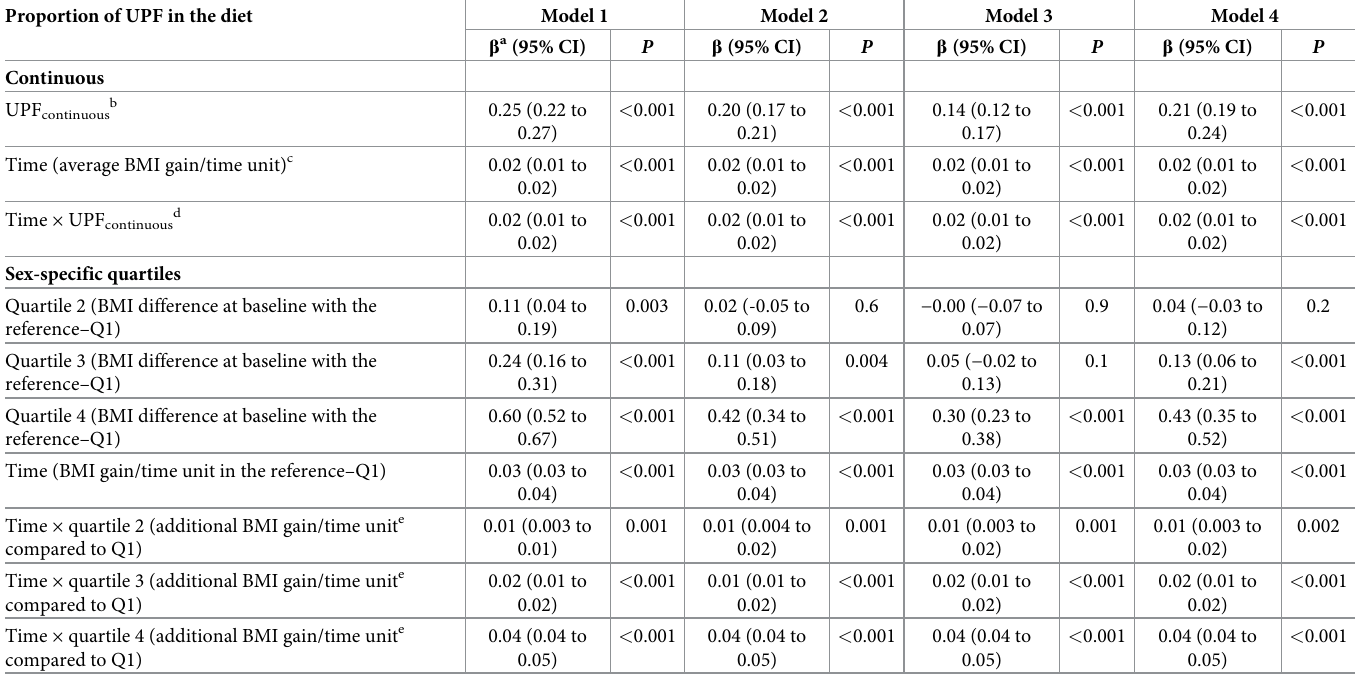
Table 2. Associations between sex-specific quartiles of UPF consumption and BMI change, NutriNet-Sante´ cohort, France, 2009–2019 ( N = 110,260). Proportion of UPF in the